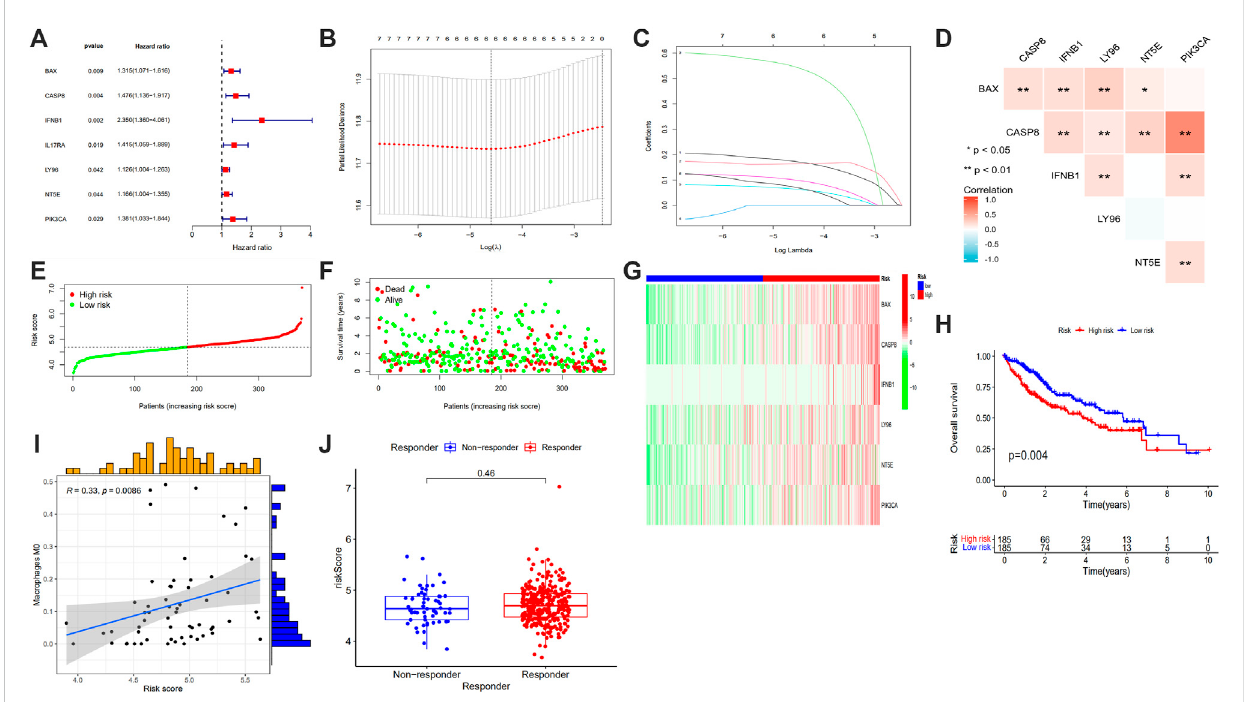
FIGURE 7 Forest plots of univariate prognostic analysis (A) , LASSO regression analysis (B) , coef fi cient pro fi le plot (C) , correlation heatmap (D) of 6 ICD associated prognosis genes, risk score plot (E) , survival status scatter plot (F) , heatmap (G) and survival curve (H) of high risk and low risk groups, correlation between the risk score and Macrophage M0 (I) and risk score in responder and non-responder groups in HCC who had received immune- checkpoint inhibitors (J) . (LASSO: least absolute shrinkage and selection operator, ICD: immunogenic cell death, HCC: hepatocellular carcinoma;